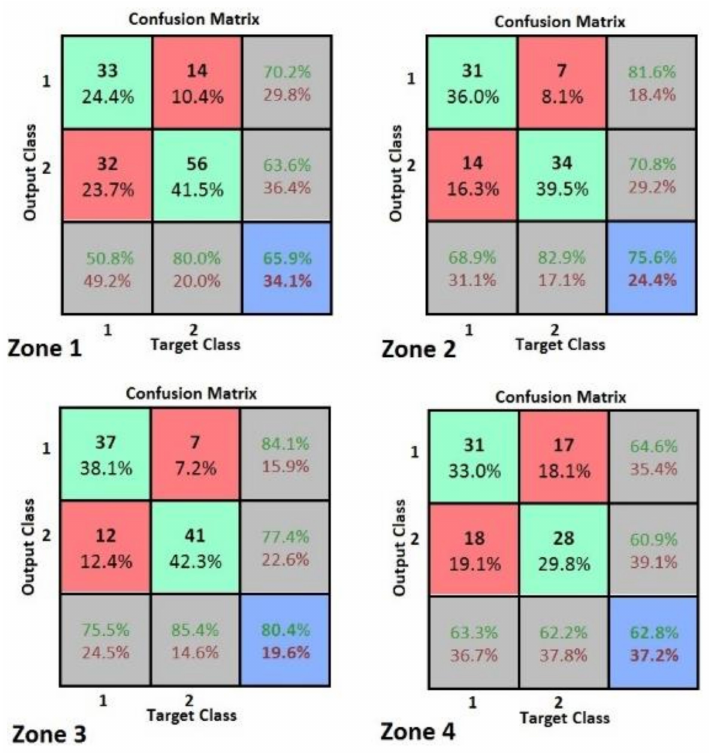
Figure 5. Test matrix of confusion for the 80–20% training-test partition in the study region. Class 1 corresponds to fires smaller than 30,000 m 2 (small fires) and class 2 to fires larger than 30,000 m 2 (big